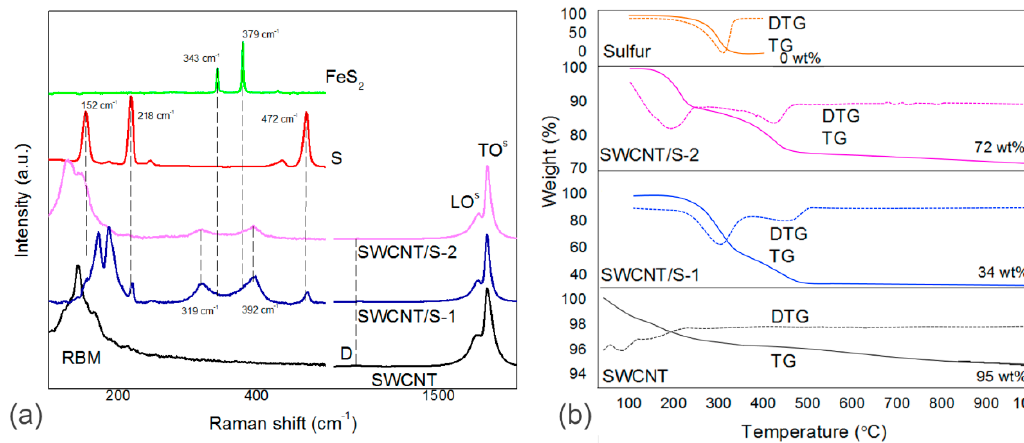
Figure 2. Raman spectra ( a ) and thermal analysis curves ( b ) of initial SWCNT, SWCNT / S-1 and SWCNT / S-2 samples in comparison with reference spectra of sulfur and pyrite.